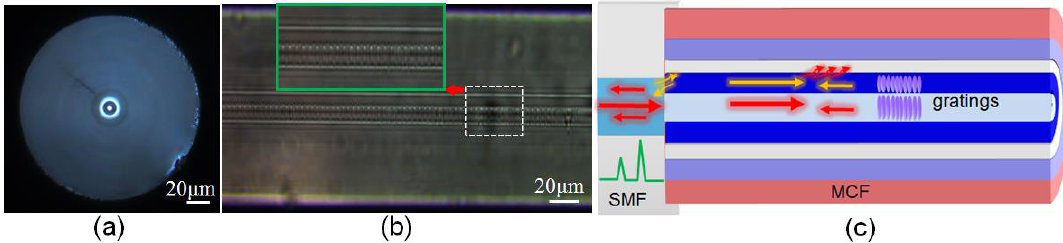
Figure 1. Schematic diagram of the experimental setup for “cladding” FBG fabrication.